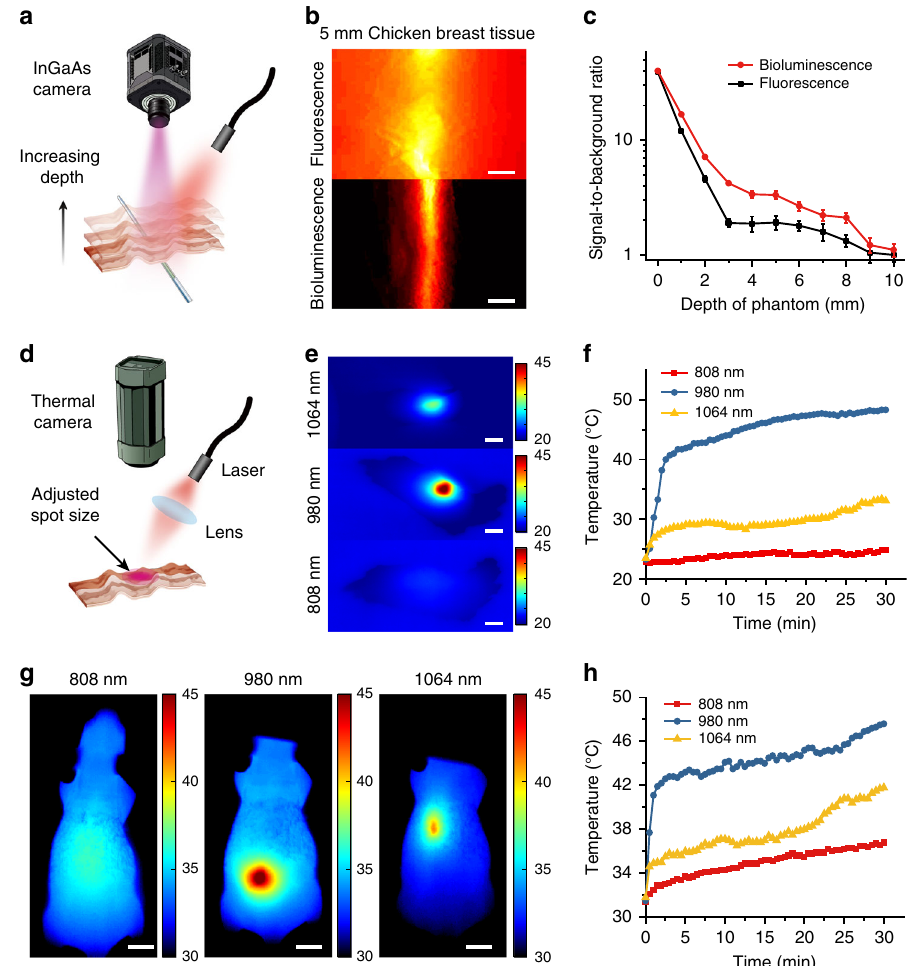
Fig. 3 Differences in signal-to-noise ratios and photothermal effects between NIR-II bioluminescence and fl uorescence imaging. a Schematic illustration of optical imaging. b NIR-II fl uorescence image (top) and NIR-II bioluminescence image (bottom) under 5mm chicken breast tissue. Scale bar, 2mm. c Signal-to-noise ratios of capillaries fi lled with NIR-II-BPs with different thicknesses of chicken breast tissue for NIR-II fl uorescence imaging and NIR-II bioluminescence imaging. Bars represent mean± s.d. derived from n = 3 independent experiments. d Schematic illustration for thermal effect study on chicken breast tissues. e Photothermal imaging of chicken breast tissue with continuous irradiation under 808nm (329 mWcm − 2 ), 980 nm (726mW cm − 2 ) and 1064nm (1070mWcm − 2 ) for 30 min. Scale bar, 5mm. f Temperature variation curves of chicken breast tissue recorded with irradiation of different excitation wavelengths. g Skin temperatures of nude mouse irradiated under 808 nm (329 mWcm − 2 ), 980nm (726 mWcm − 2 ) and 1064nm (1070mWcm − 2 ) after 30min. Scale bar, 1 cm. h Temperature variation curves of nude mouse skin recorded with irradiation of different excitation wavelengths. Source data underlying f , h are provided as a Source Data fi